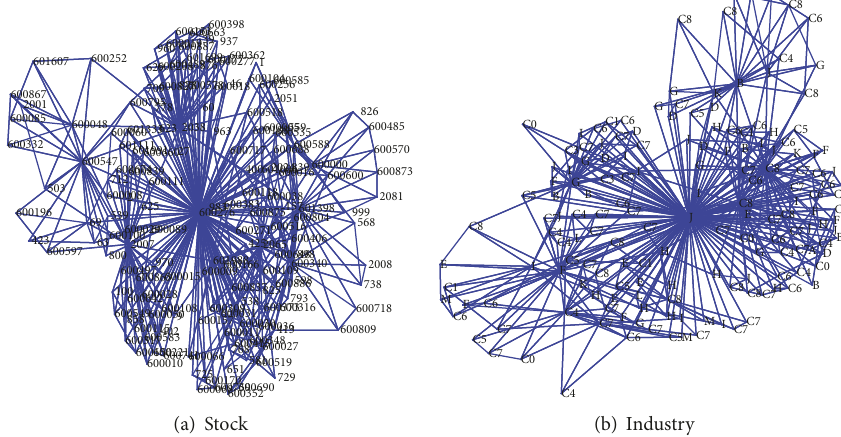
Figure 17: CSI163 PMFG. We label the vertices with stock codes in (a) and industry codes in (b).